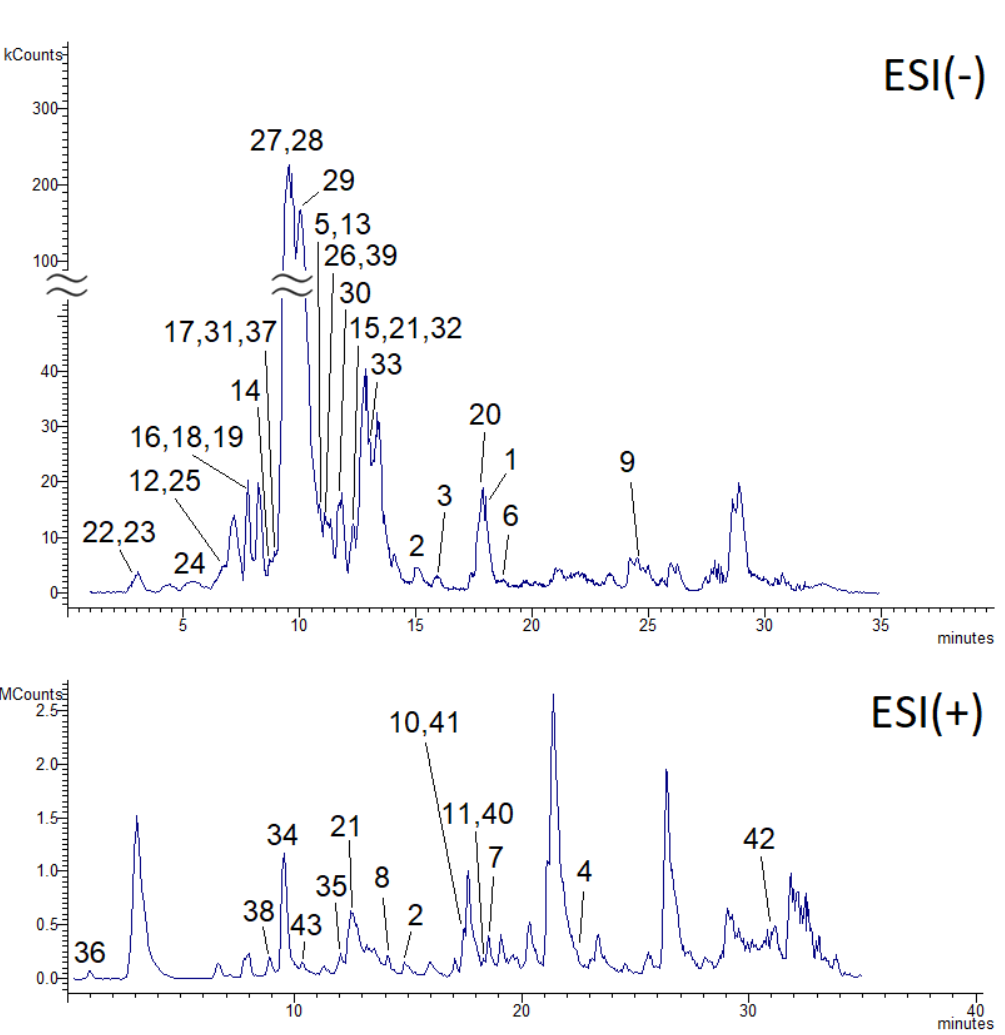
Figure 1. Intensity of base peak chromatograms obtained from the LC-MS n analysis of Colebrookea oppositifolia methanol extract (COME) in ESI( − ) (upper panel) and ESI( + ) (lower panel) modes. The numbers in the chromatograms indicate the tentatively identified phytoconstituents, as reported in Table 1.